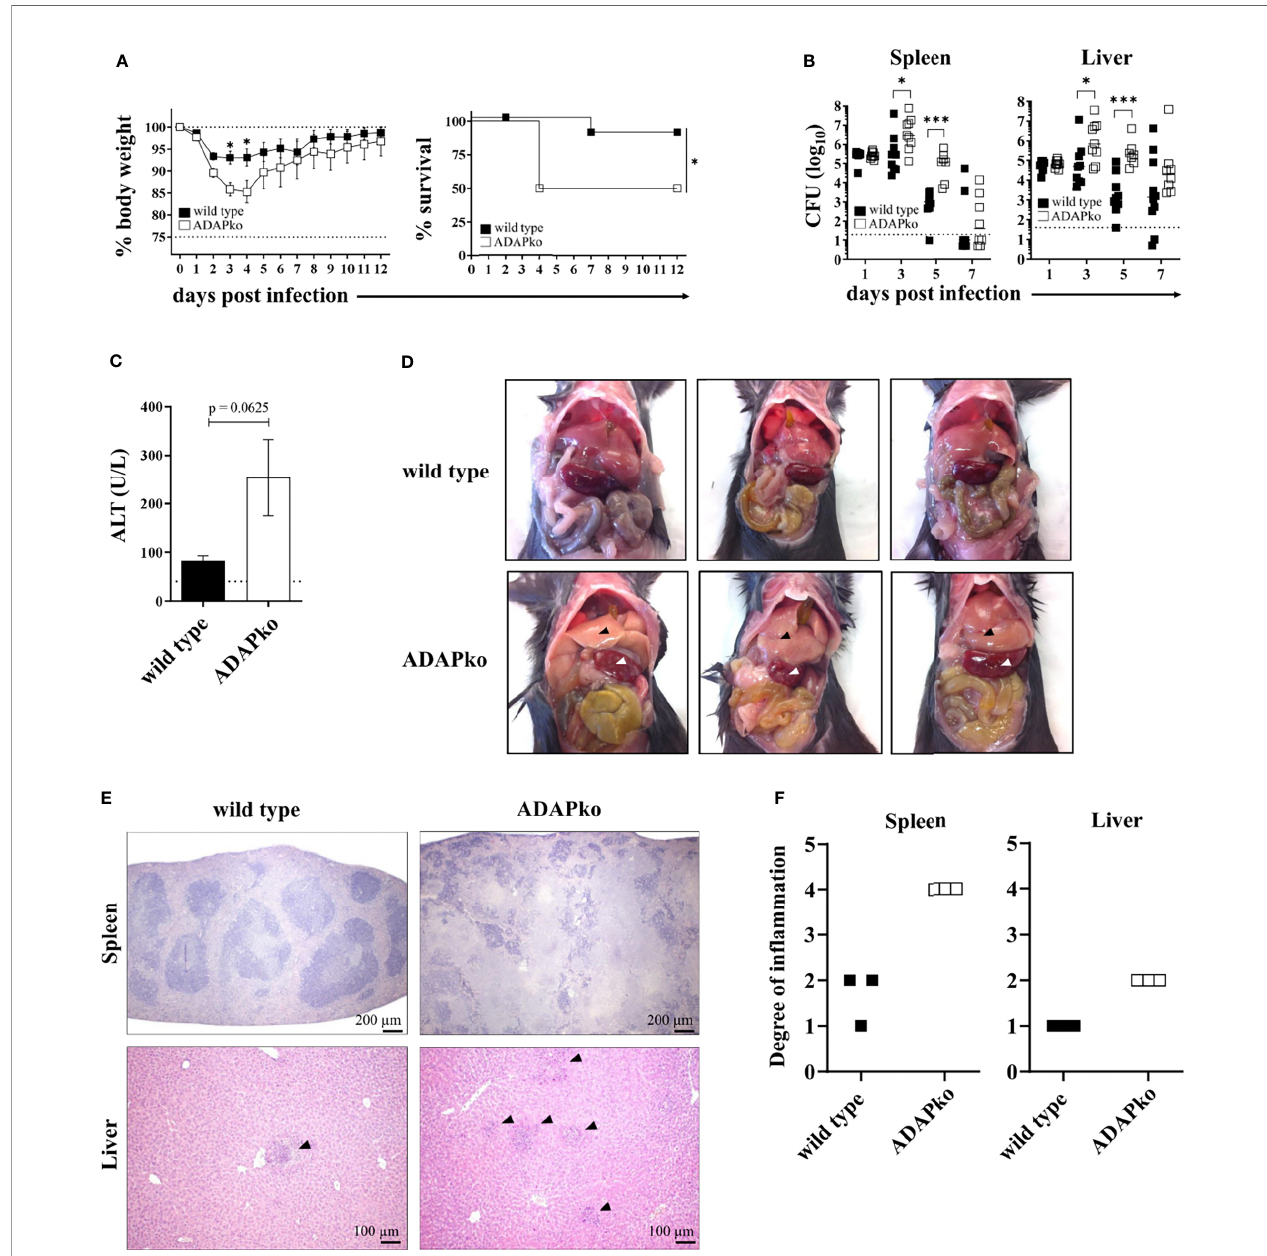
FIGURE 1 | ADAP-de fi ciency renders mice highly susceptible to infection with the intracellular pathogen Listeria monocytogenes ( Lm ). Wild type ( ▪ ) and ADAPko ( ▫ ) mice were either infected i.v. with (A) 5 × 10 4 CFU, (B, C, E, F) 2.5 × 10 4 CFU, and (D) 1 × 10 4 CFU Lm (strain 10403S) or were left untreated (uninfected control mice, day 0) and were sacri fi ced at the indicated times post infection. (A) Infected mice were weighed and monitored daily, and the survival was reported. Data are depicted as mean ± SEM for n = 8 – 14 individually analyzed mice. Statistical analyses were performed using two-way ANOVA with Bonferroni ’ s post-hoc test for the weight data and Mantel – Cox log-rank test for the survival data. (B) Bacterial loads in the spleen and liver after Lm infection. The dashed line represents the limit of detection. Data are depicted as medians for n = 8 – 10 individually analyzed mice. Statistical analyses were performed after log 10 -transformation using two-way ANOVA with Bonferroni ’ s post-hoc test. (C) Serum ALT levels 3 days post infection were determined. Levels higher than the dashed line are considered elevated and indicative of liver damage. Data are depicted as mean ± SEM for n = 5 individually analyzed mice. Statistical analyses were performed using two-tailed